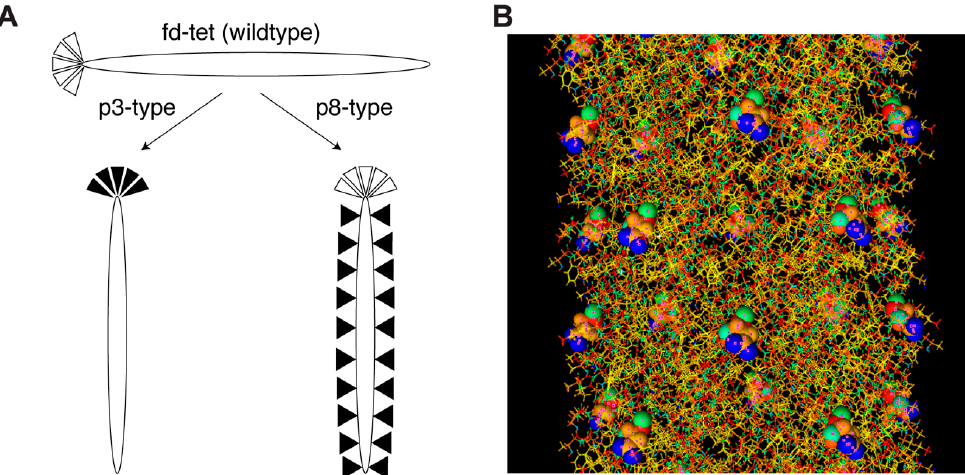
Figure 1. Major types of phage display libraries. ( A ) Schematic diagrams of p3-type versus p8-type phage display libraries derived from the fd-tet parent vector (display on other minor coats or hybrid type libraries are not shown). Filamentous phage, fd-tet, is represented as a thin, flexible rod ~1 µm in length by 6 nm in diameter and is composed of a circular, single stranded DNA genome encapsulated by 5 structural proteins (p3, p6, p7, p8, and p9). The most prominent protein encloses the ssDNA genome in ~4000 copies of the p8 major coat protein (depicted as an oval in the diagram). At each end of the phage, there are 5 copies of each minor coat proteins with p3 and p6 at one end and p7 and p9 at the other end (here, only the p3 protein is depicted and is shown as an open triangle). Introduction of a foreign, degenerate oligonucleotide sequence at the N-terminus of either p3 or p8 coat proteins leads to display of a peptide fusion on each respective coat protein (indicated as a filled black triangle). In type 3 libraries, the foreign fusion peptide is displayed on all 5 copies of the p3 minor coat protein. In alternative type 8 libraries—or landscape phage display libraries, the foreign fusion peptide is displayed on all 4000 copies of the p8 major coat protein leading to dramatic changes to the surface properties of each phage particle. ( B ) A stick model diagram of the landscape phage